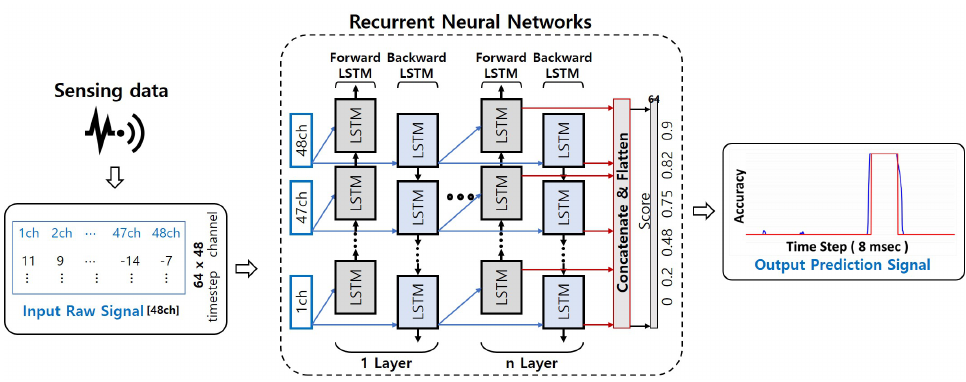
Figure 9. Signal learning with convolution neural networks